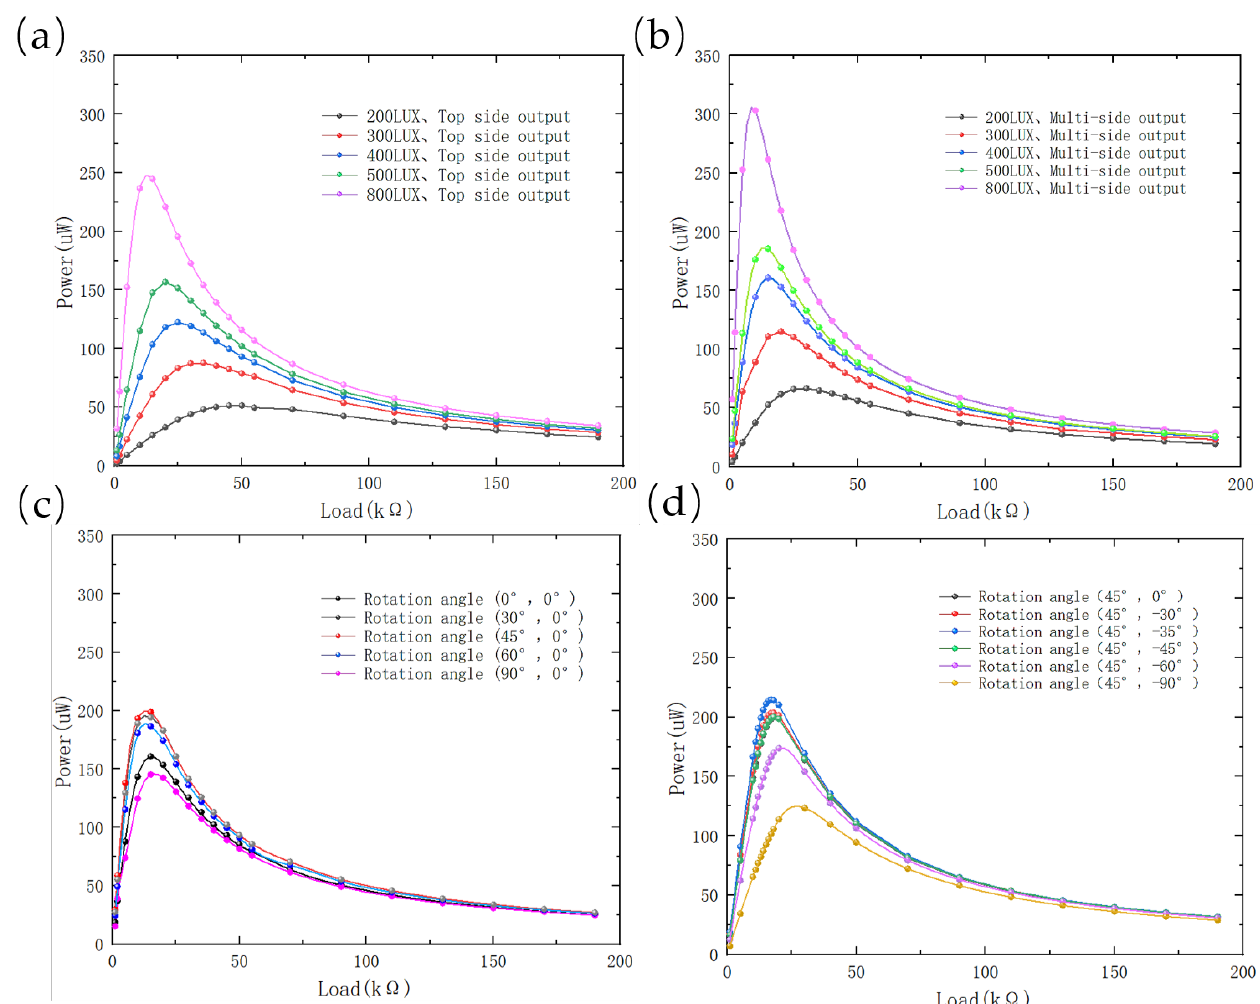
Figure 9. ( a ) P-R curves for single-sided PV; ( b ) P-R curves for multi-sided PVs; ( c ) P-R curves for single-sided PV with different rotation angles (fixed light intensity 400 lux, rotation around X-axis); ( d ) P-R curves for multi-sided PVs with different rotation angles (fixed light intensity 400 lux, rotation around Y-axis). The point data in the graphs were measured and the curves were fitted after three interpolations of the point data.